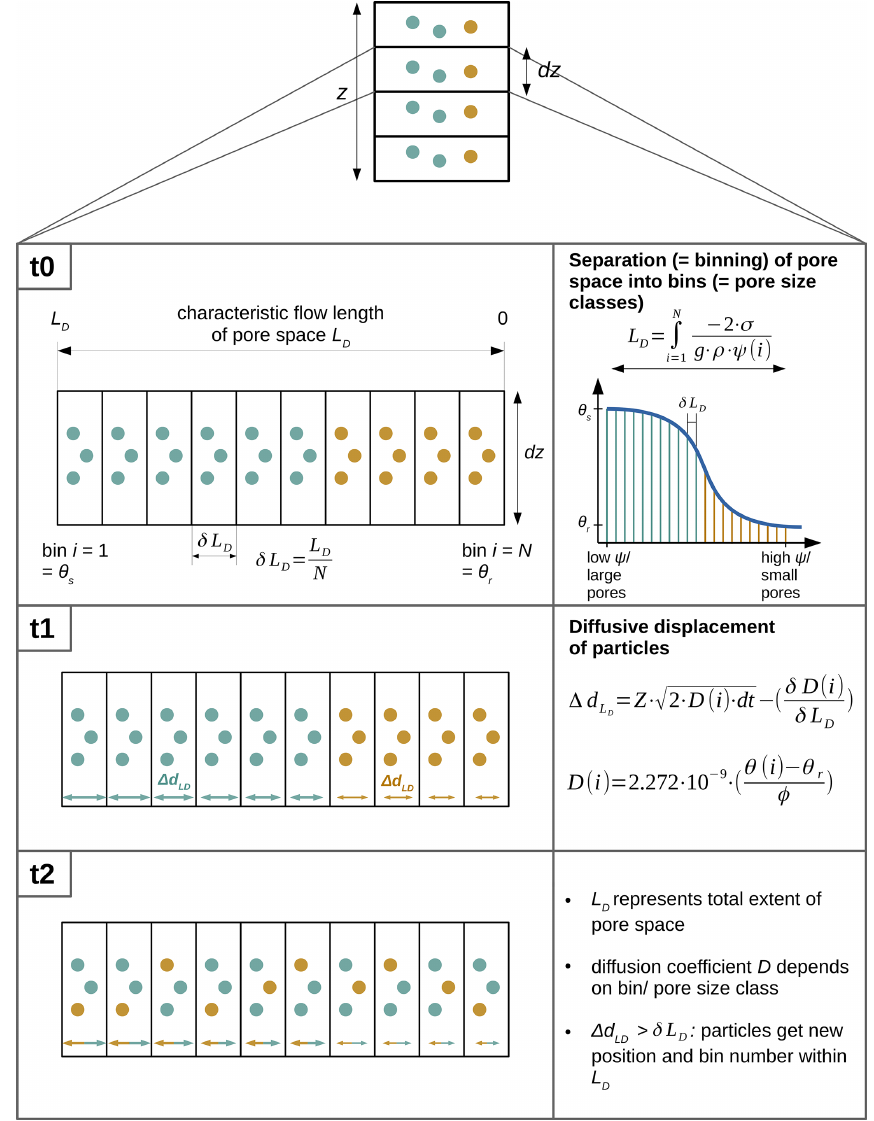
Figure 1. Schematic sketch of the diffusive pore mixing (DIPMI) approach. See the descriptions of Eqs. (1)–(4) in Sect. 2.2 for further information on the